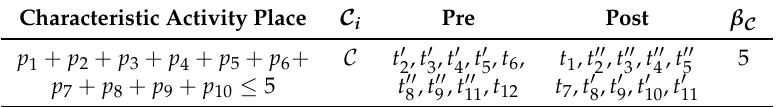
Table 1. Overall decentralized controllers for the Petri net model are shown in Figure 2. Characteristic Activity